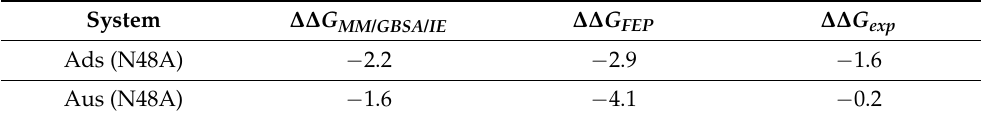
Table 3. The differences in binding free energy caused by the N48A mutation calculated with MM/GBSA/IE and FEP. All values are in kcal/mol.